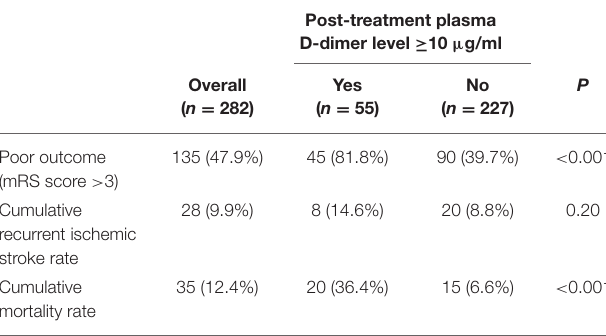
TABLE 2 | Clinical outcomes 30 days after admission according to the post-treatment plasma D-dimer